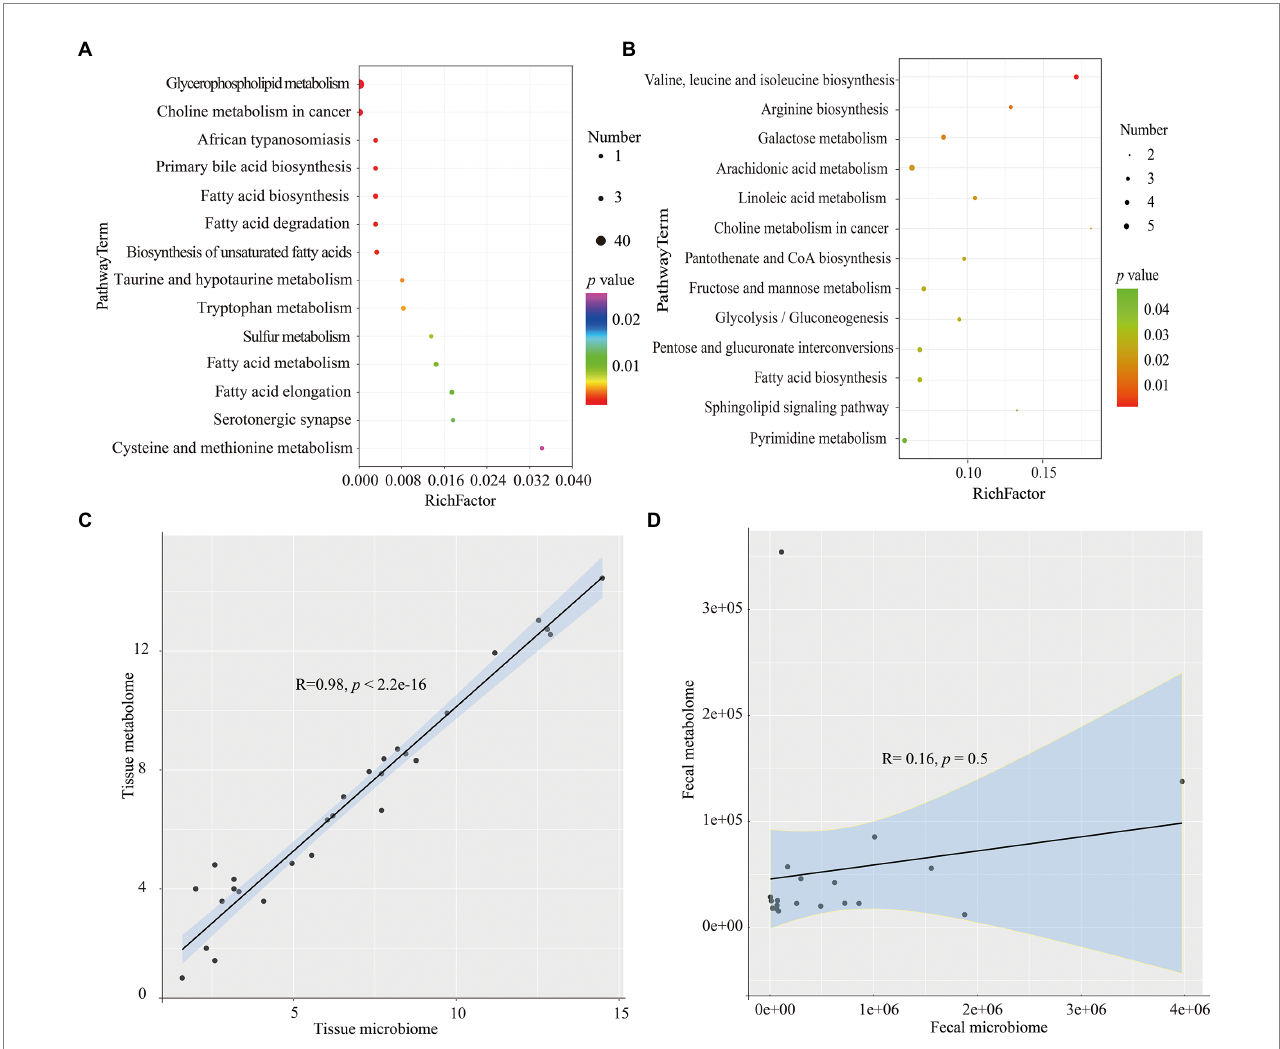
FIGURE 4 KEGG analyses of the differential metabolites the T HC and T CRC (A) , and between the F HC and F CRC groups (B) , respectively. Correlation between microbiome and metabolomics data for T HC vs. T CRC (C) , and F HC vs. F CRC (D) . * p < 0.05, ** p < 0.01 and *** p < 0.001. Red: positive correlation; blue: negative